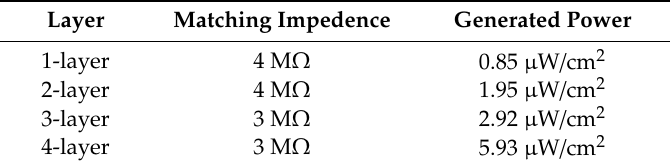
Table 3. Generated power of the 1–4 layer BS-PT piezoelectric energy